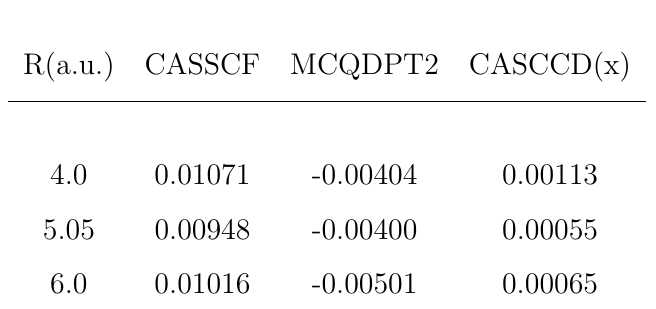
Table 2. Calculations of the lowest singlet excited states of Li at three internuclear distances near the equilibrium geometry. Calculation performed with the 6-31G basis set. The values shown are differences between the FCI energies and the CASSCF, MCQDPT2, CASCCD(x) energies in atom